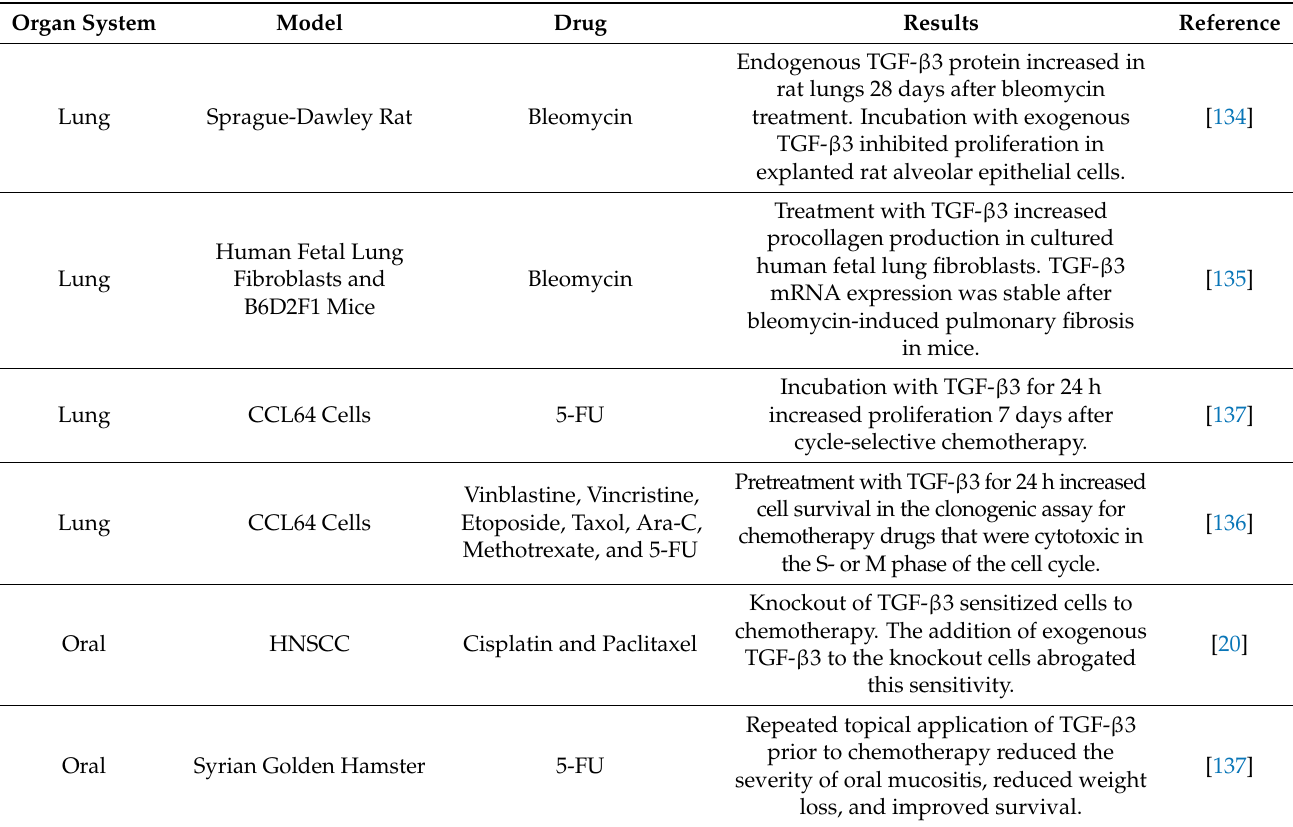
Table 5. Studies of treatment with exogenous TGF- β 3 in combination with chemotherapy in vitro, in vivo and in clinical trials. HNSCC: Head and neck squamous cell carcinoma; 5-FU: